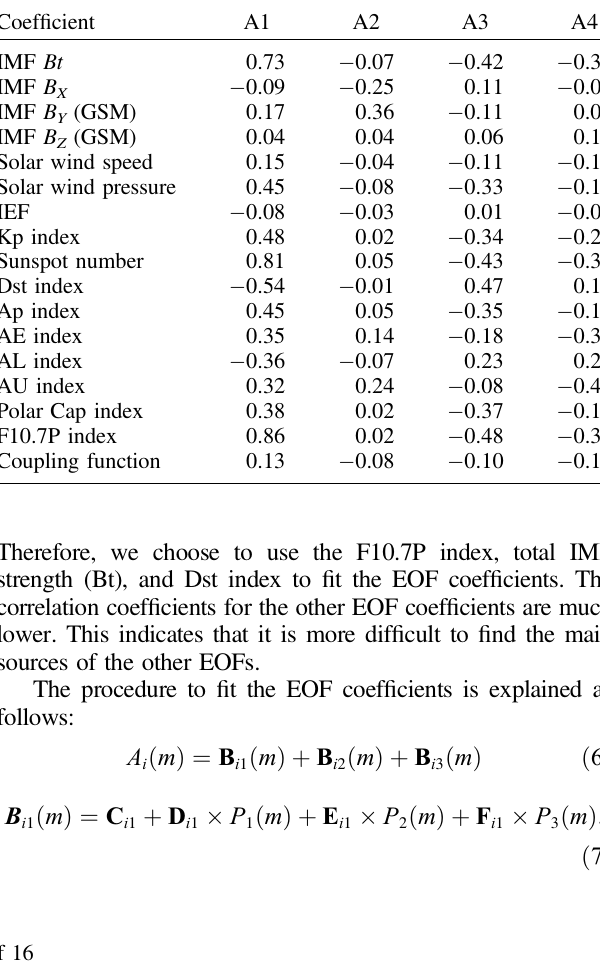
Table 2. Correlation coef fi cients of the commonly used solar and geomagnetic indices with the fi rst 4 EOF coef fi